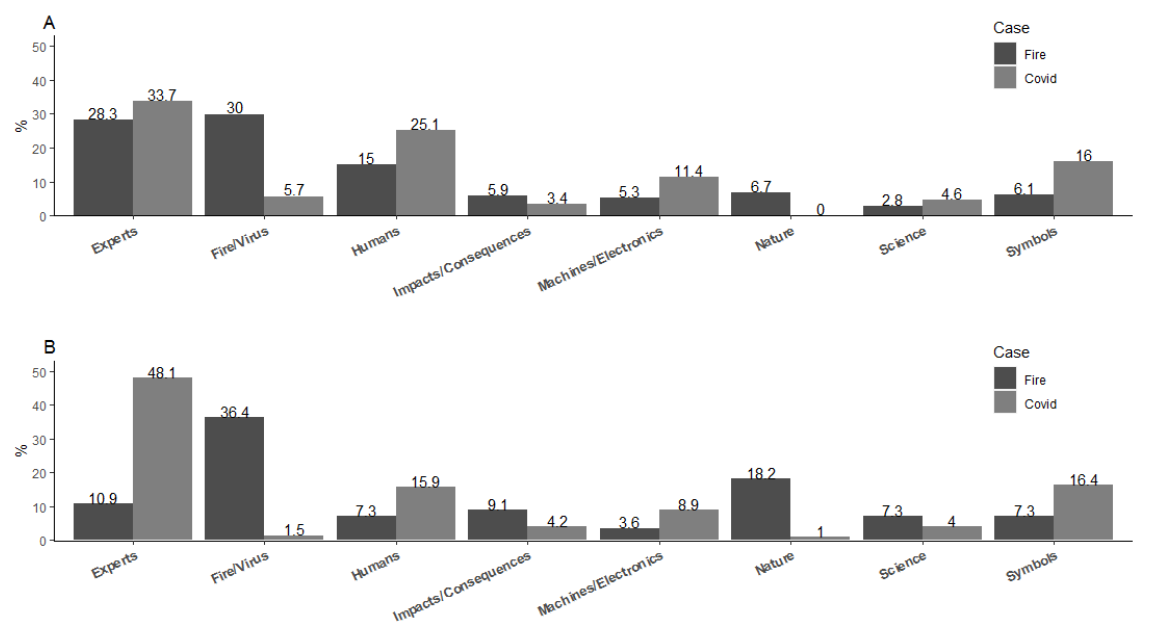
Figure 4. Denotative frames of the images, The New Daily ( A ) and Index ( B ). Concerning the bushfires, Hazards was the leading connotative frame on both sites; however, there was no correlation between the other frames (Figure 5). On TND, Expertise, Hope, and Joy were portrayed in around 10% of cases, Incompetence in almost 6% of cases, and hardly any picture suggested Devastation. In contrast, on Index almost a third of the pictures were about Devastation and a fifth about Hope; but the other frames were hardly represented.